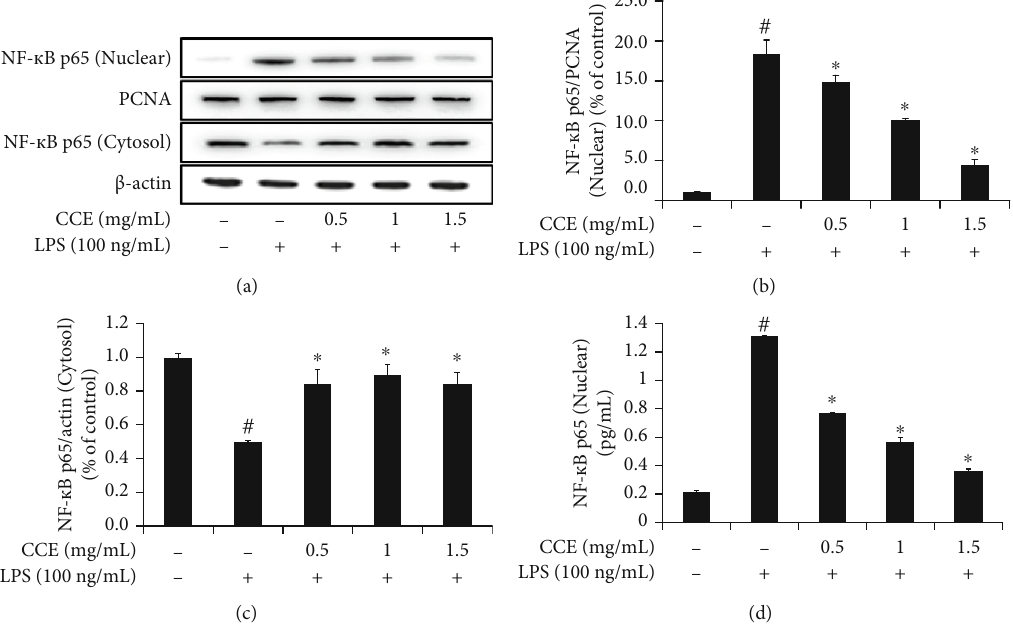
Figure 5: Commelina communis extract (CCE) treatment hinders activation of the p65 subunit of nuclear factor- (NF-) κ B in RAW 264.7 cells. Murine macrophages were treated with CCE for 4h and then exposed to lipopolysaccharide (LPS) for 1h. (a) NF- κ B p65 expression levels in the nuclear and cytosolic protein fractions were detected using western blotting and quanti fi ed using standard solutions of PCNA (b) and β -actin (c), respectively. (d) Nuclear NF- κ B was assessed using enzyme-linked immunosorbent assay. Data are expressed as the mean ± standard deviation from three independent experiments. # P < 0 : 05 compared with the control; ∗ P < 0 : 05 compared with the LPS- exposed group.